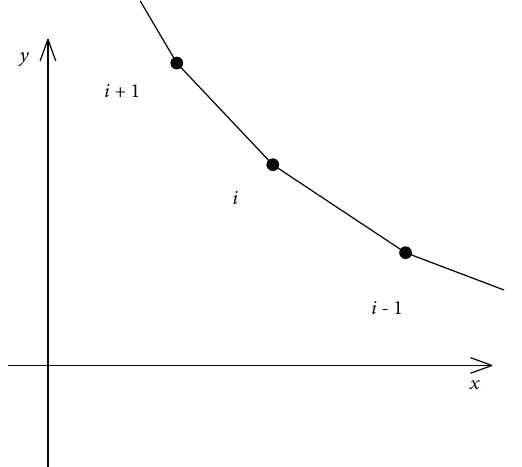
Figure 4: Mass-spring-damper model.